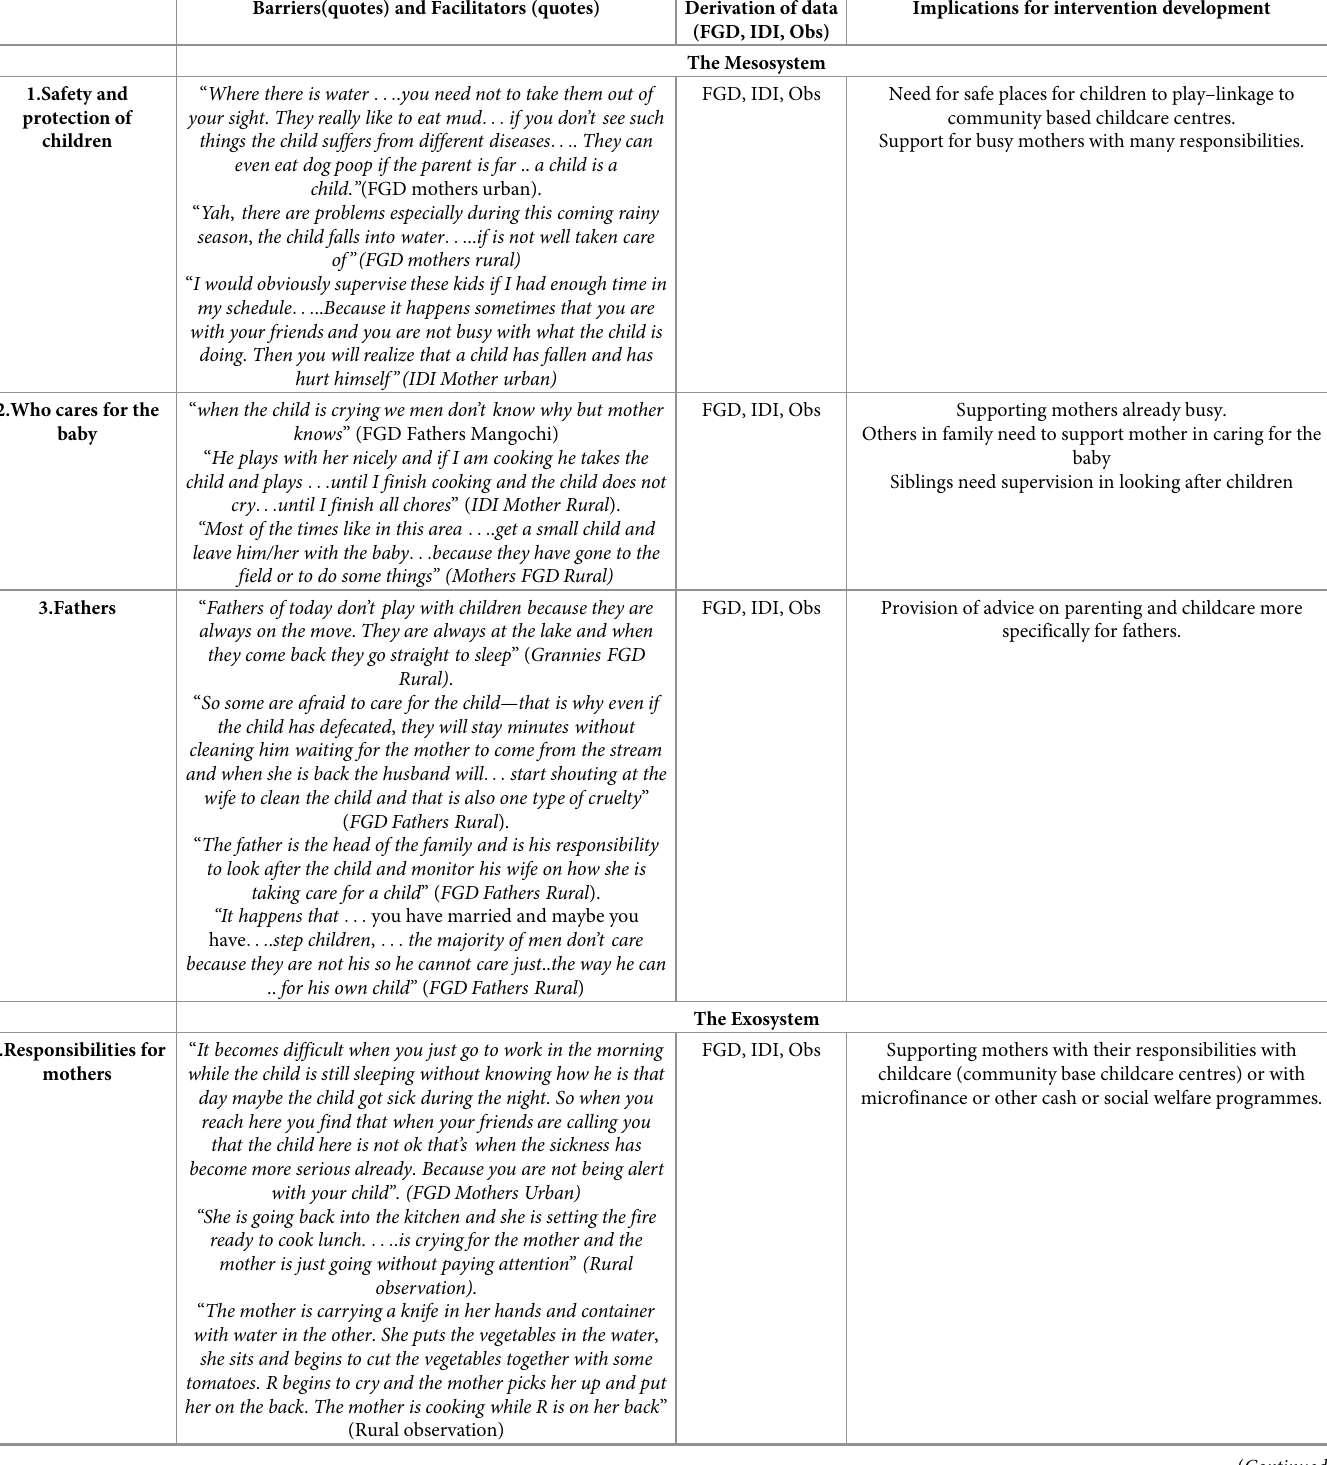
Table 5. Barriers and enablers to care, responsiveness, play and stimulation at the level of the community and society (Mesosystem and Exosystem). Barriers(quotes) and Facilitators